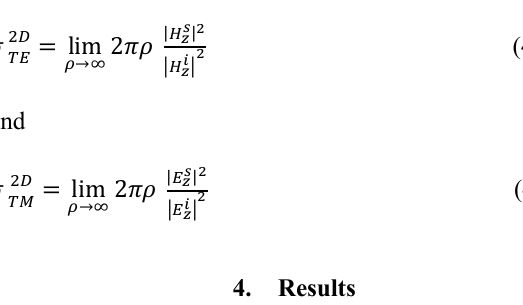
and 𝐸 over a 2 & = 1.8 − 𝑗0.1 and Q#